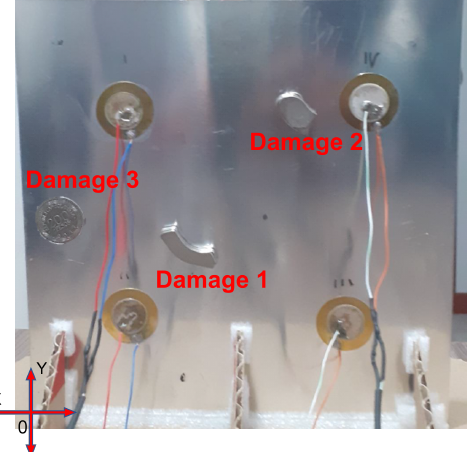
Figure 14. Damages position in the aluminium plate.